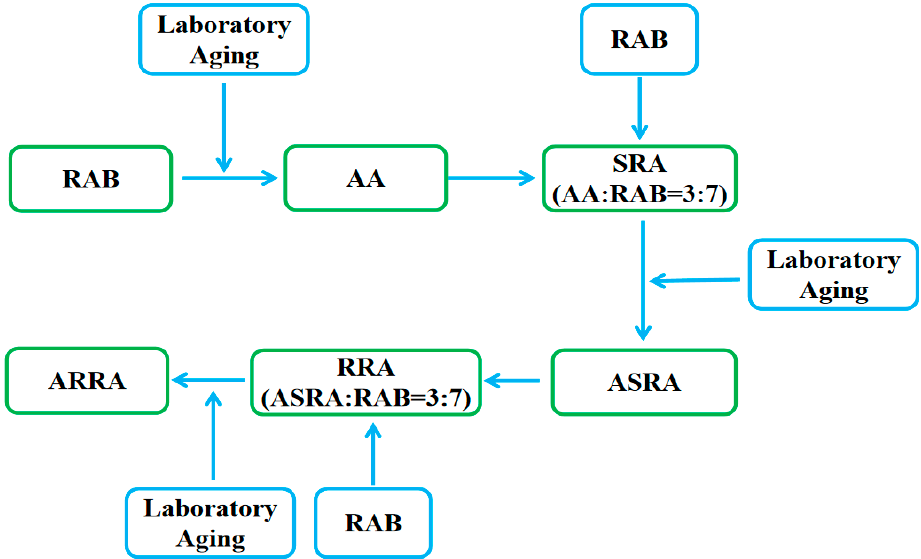
Figure 1. Re-recycled asphalt binder preparation process.